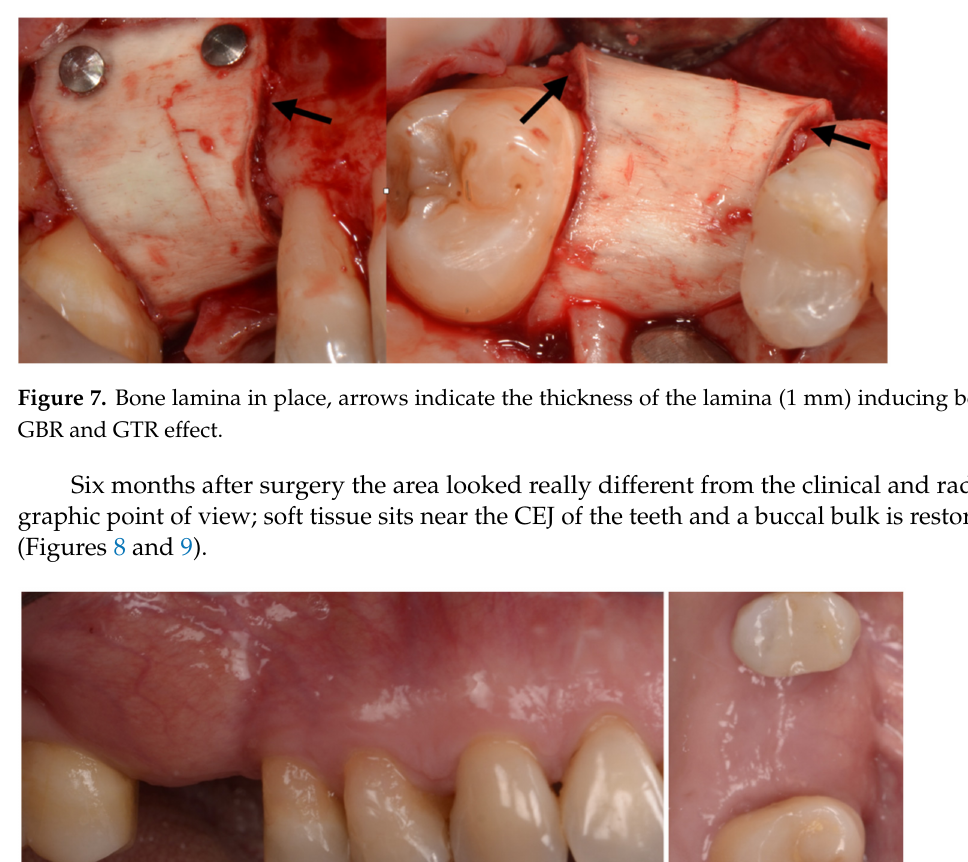
4.0 resorbable sutures and healing was uneventful.